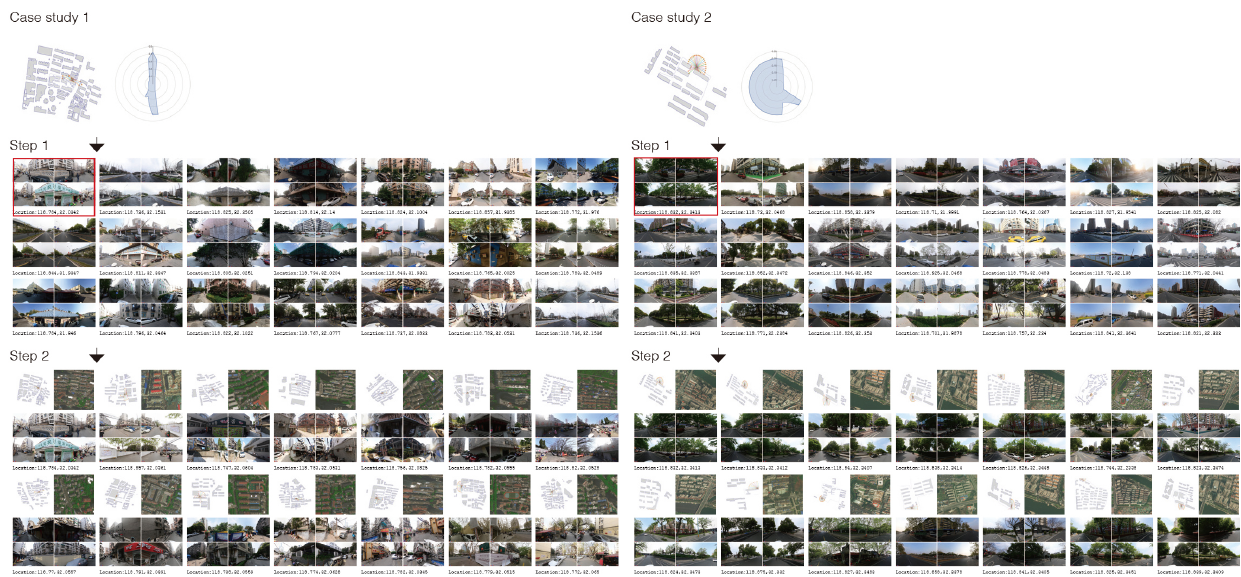
Figure 11. Query for locations and SVIs that have similar spatial characteristics with the input marked with a red box (step 1) and query for case packages according to the selected SVIs (marked with a red box) based on the step 1 output (step